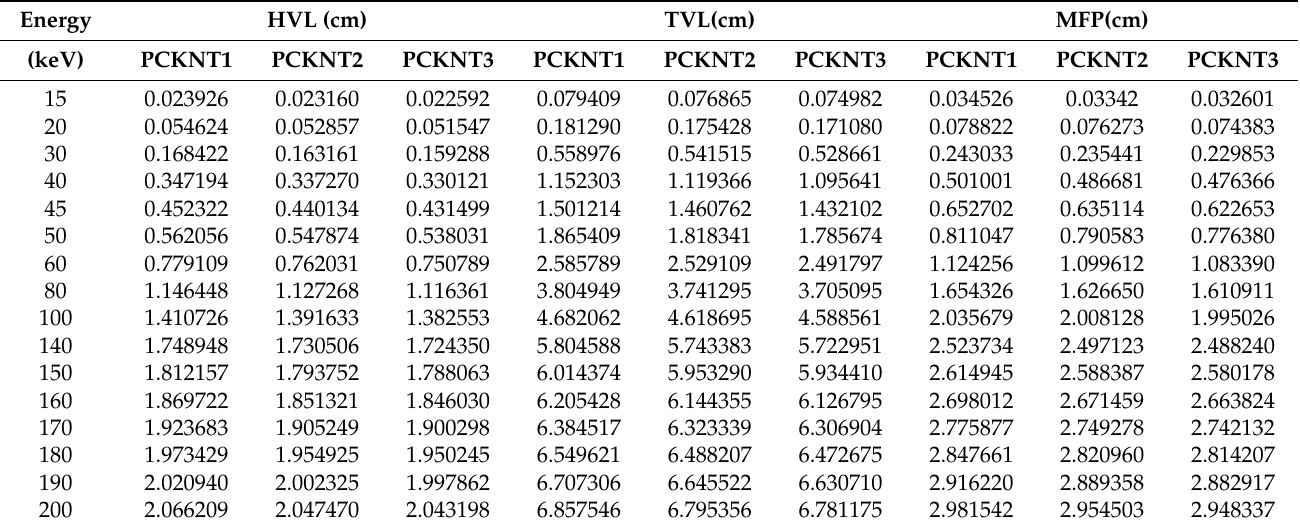
Table 5. Half-value layer, tenth value layer, and the mean free path of prepared PCKNT